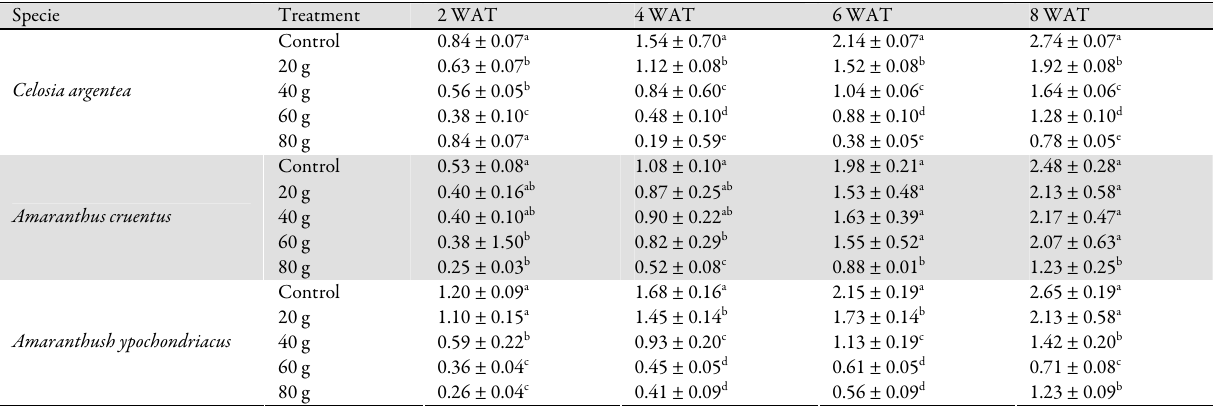
Means within the column followed by the same letters are not significantly different at p ˂ 0.05. Table 4. Mean stem girth of the studied leafy vegetables to the allelopathic effect of Vitellaria parodoxa leafs